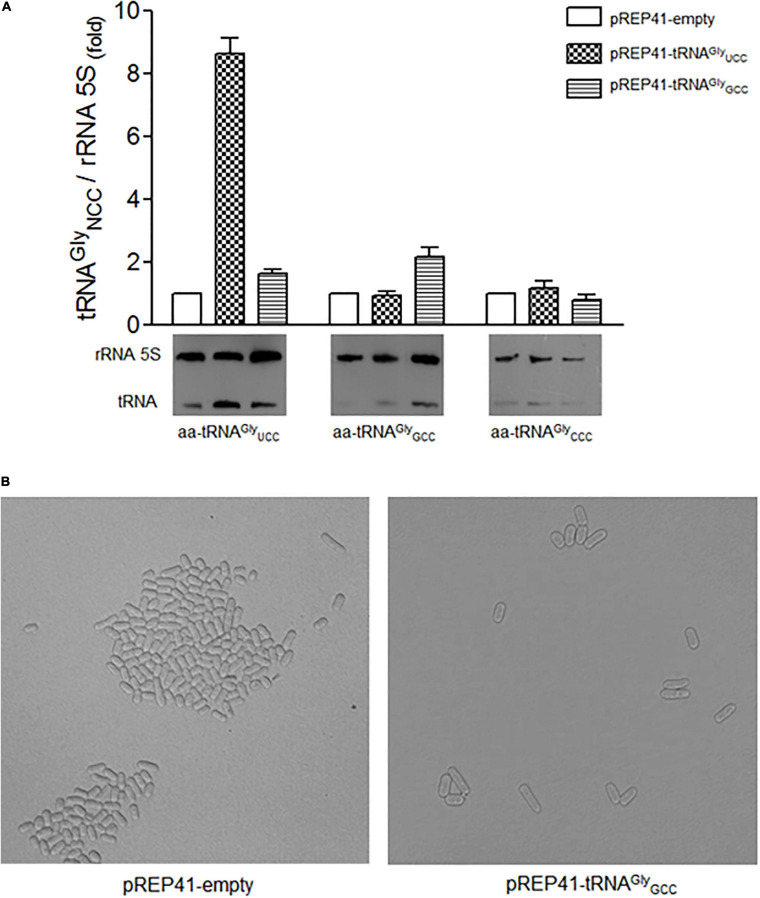
Overexpression of tRNAGlyGCC did not change the level of other tRNAGly isoaceptors and did not cause morphological changes in cell elongation. (A) Relative levels of tRNAGlyUCC, tRNAGlyGCC, tRNAGlyCCC isoacceptors in cells transformed with the indicated constructs. (B) Phenotype observed under a microscope of cells overexpressing tRNAGlyGCC synchronized with 15 mM HU for 4 hrs. The images were obtained under a microscope at 400x at 12 hrs post-incubation with HU (cell cycle stage: G2).